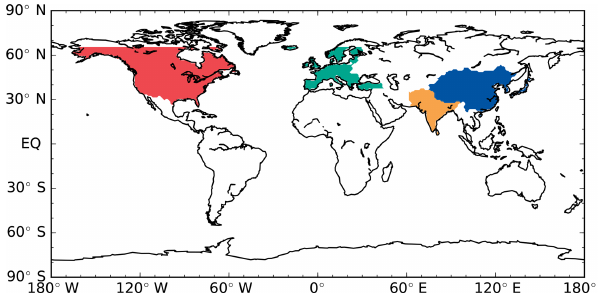
Figure 1. Emission regions according to the HTAP definition. The regions are labelled as follows: Europe (EU) is shown in green, North America (NA) is shown in red, East Asia (EA) is shown in blue and South Asia (SA) is shown in